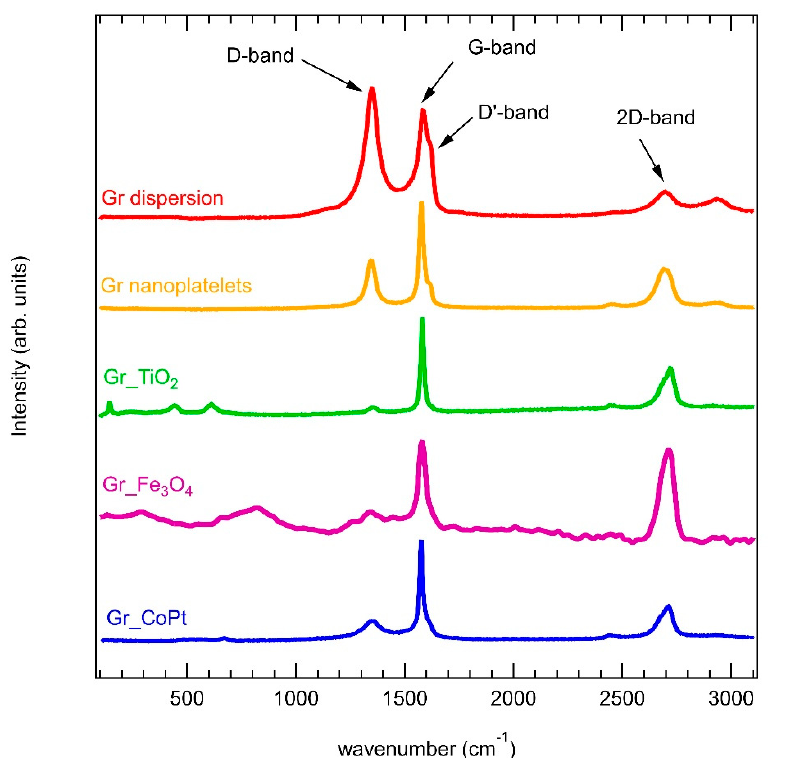
Figure 2. Representative Raman spectra of Gr dispersion (red), Gr_nanoplatelets (yellow), Gr_TiO 2 (green), Gr_Fe 3 O 4 (purple), and Gr_CoPt (blue) samples. All the spectra have been normalized at the G peak, in order to emphasize the presence of the D ‐ band.